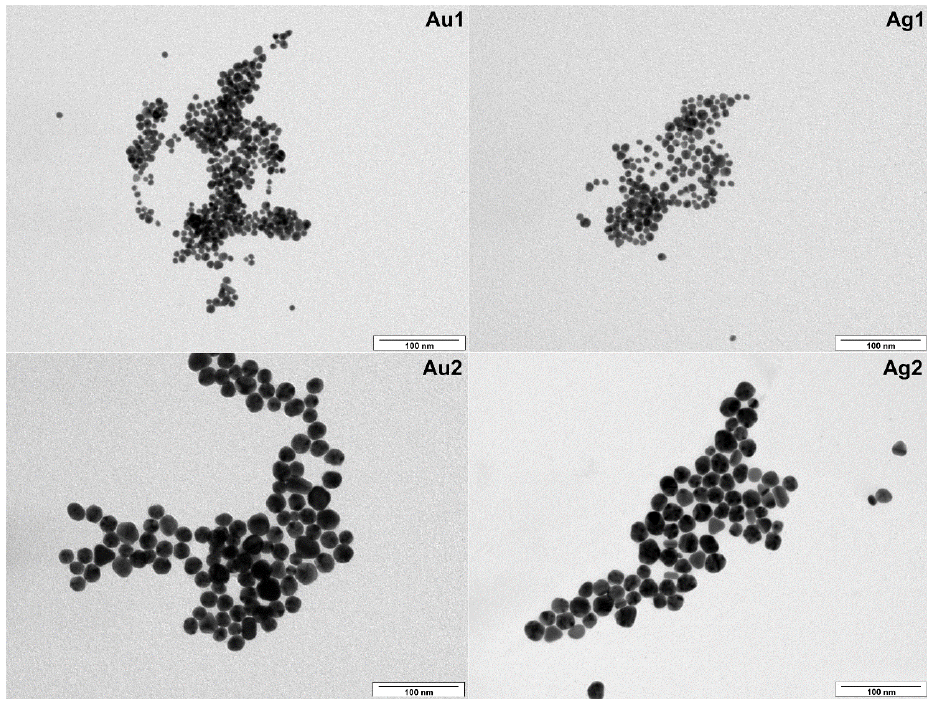
Figure 1. TEM images of AuNPs and AgNPs nanoparticles with average sizes of 12–15 nm (Au1, Ag1) and 22–25 nm (Au2, Ag2).